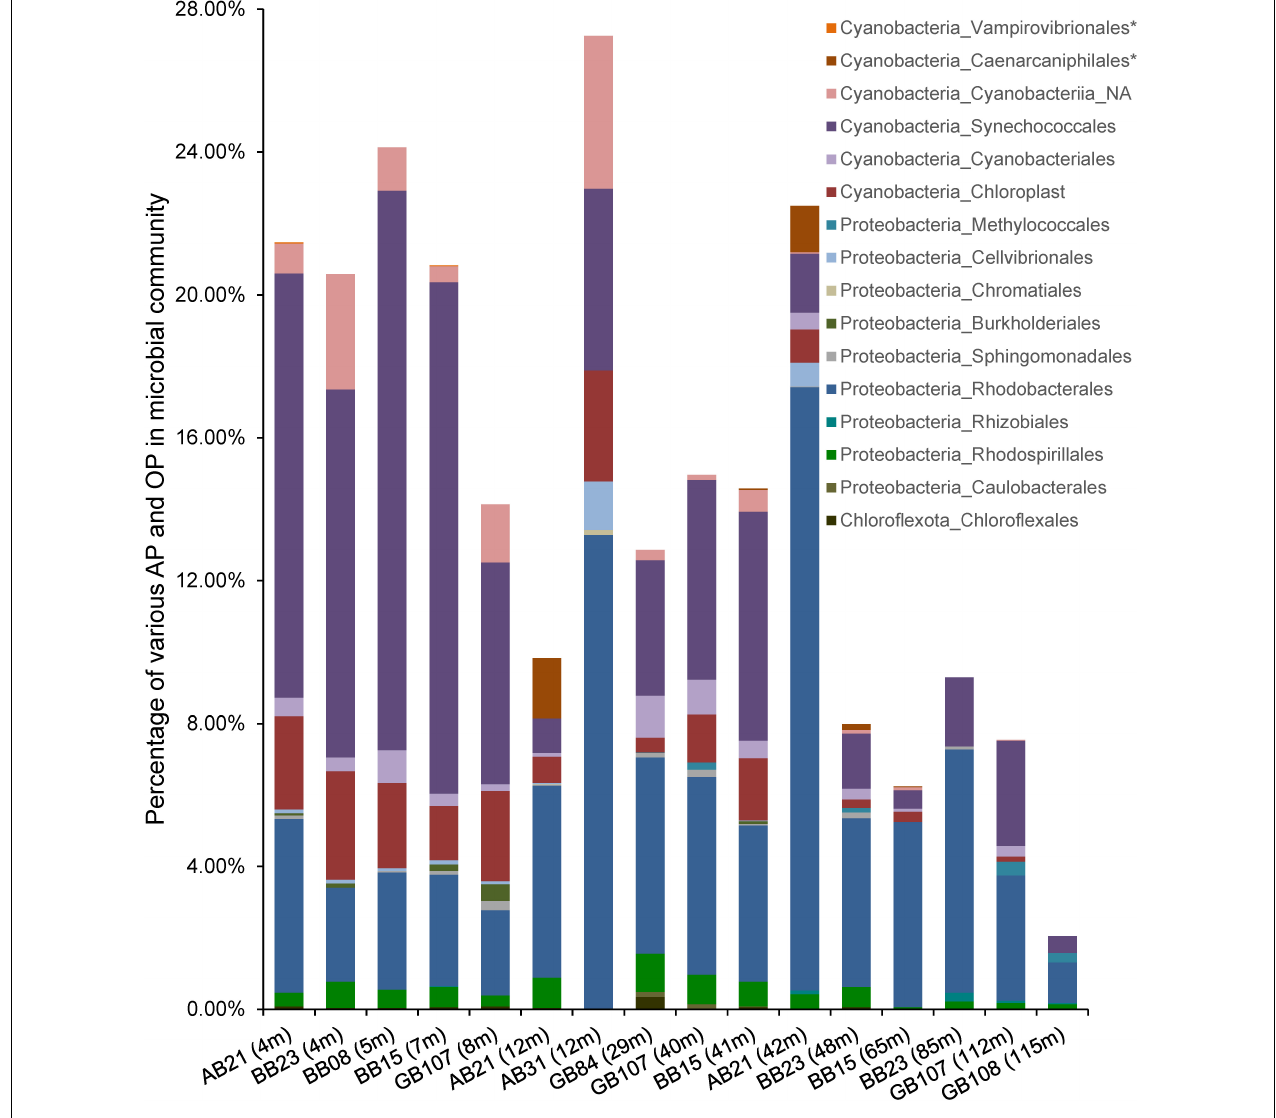
FIGURE 6 | Percentage of various AP and OP (Cyanobacteria) in the microbial community in the Baltic Sea. * Means non-phototrophic Cyanobacteria.